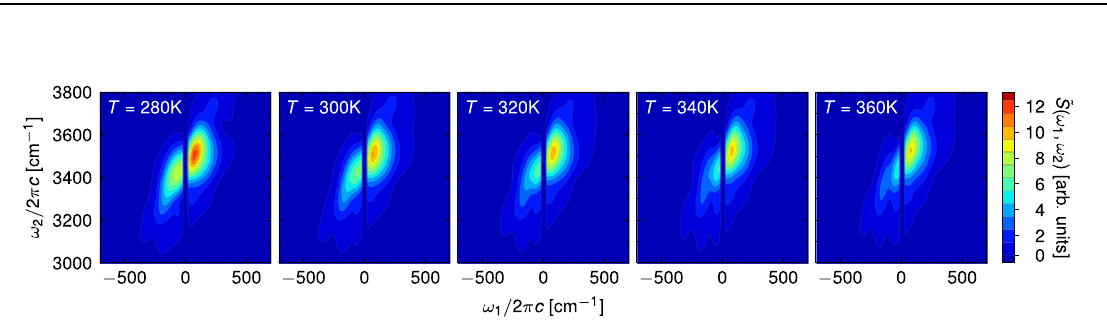
Fig.5|TemperaturedependenceoftheTIRVspectrumrelatedtotheexperimentofref.47. Two-dimensionalTIRVspectraofliquidwateratdifferenttemperatures,as calculated using Eq. (4) and time-dependent response functions R ( t 1 , t 2 ) equal to those used in Fig.